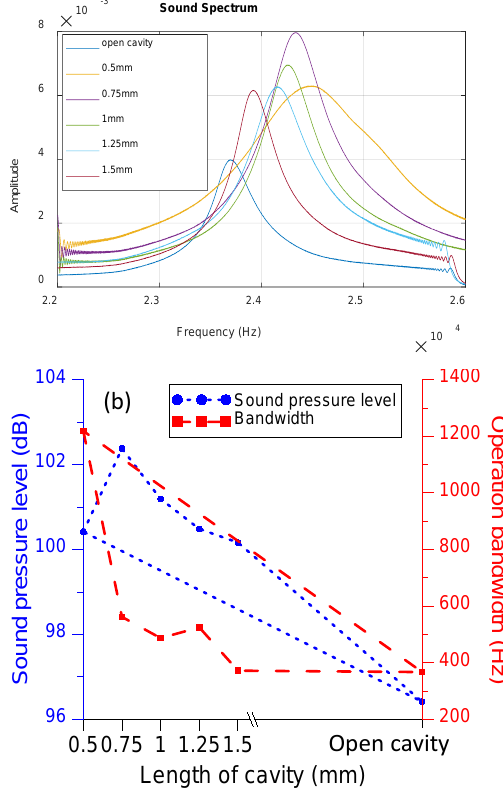
Figure 8. ( a ) Experimental results of sound frequency spectrum for the varied cavity lengths of the PMUT. ( b ) The sound pressure level and 3 dB bandwidth for the results in ( a ).